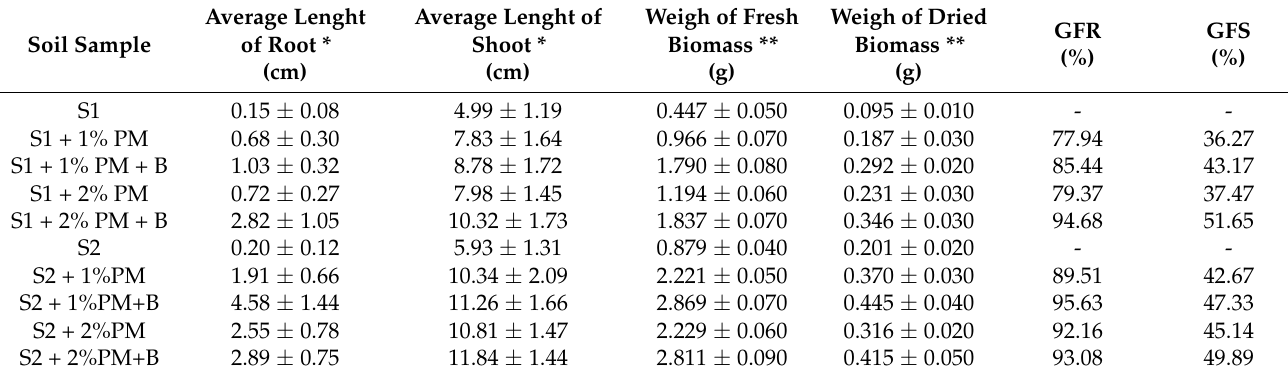
Table 6. The effect of PM treated with CaO 2 on the plant growth and biomass weight of a grass seed mixture.